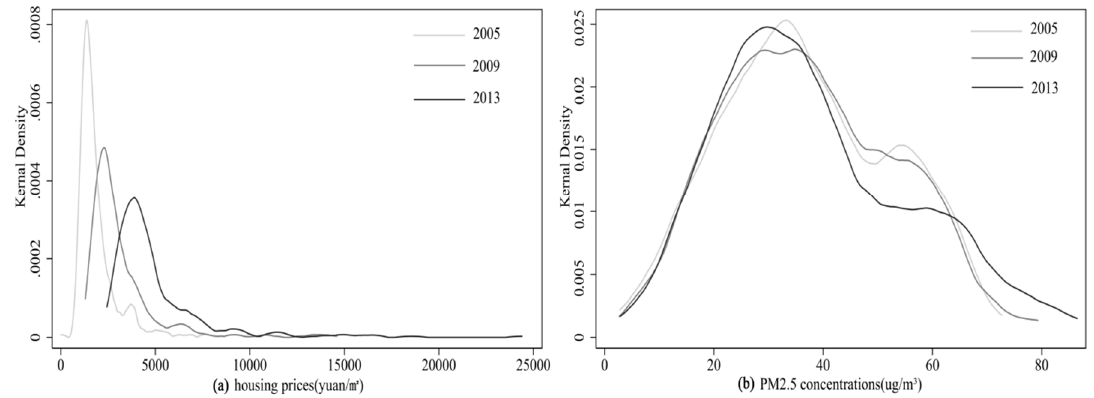
Figure 2. Kernel density estimate (KDE) of housing prices and PM2.5 concentrations. ( a ) Housing prices (yuan/m 2 ). ( b ) PM2.5 concentrations (µg/m 3 ).